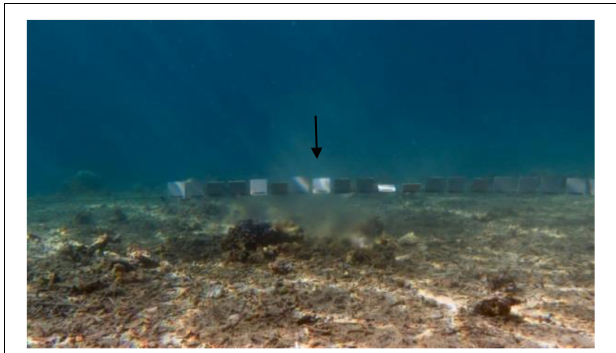
FIGURE 3 | Settlement panels (10 × 10 cm) stringed on a rope and fastened across the submarine spring ( ↓ ).